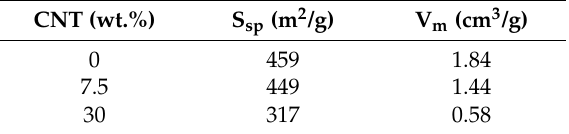
Table 2. Properties of alginate hybrid aerogel beads with